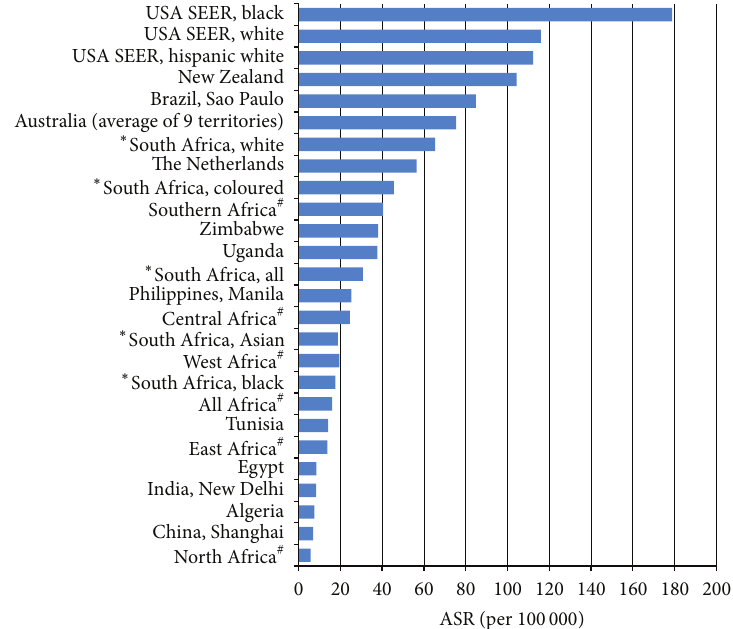
Figure 5: Comparison of age standardised rates (ASR) per 100 000 for prostate cancer from Curado et al. 1998–2002 [5], Parkin et al. 2002 (#) [37], and South African pathology based National Cancer Registry 2006 ( ∗